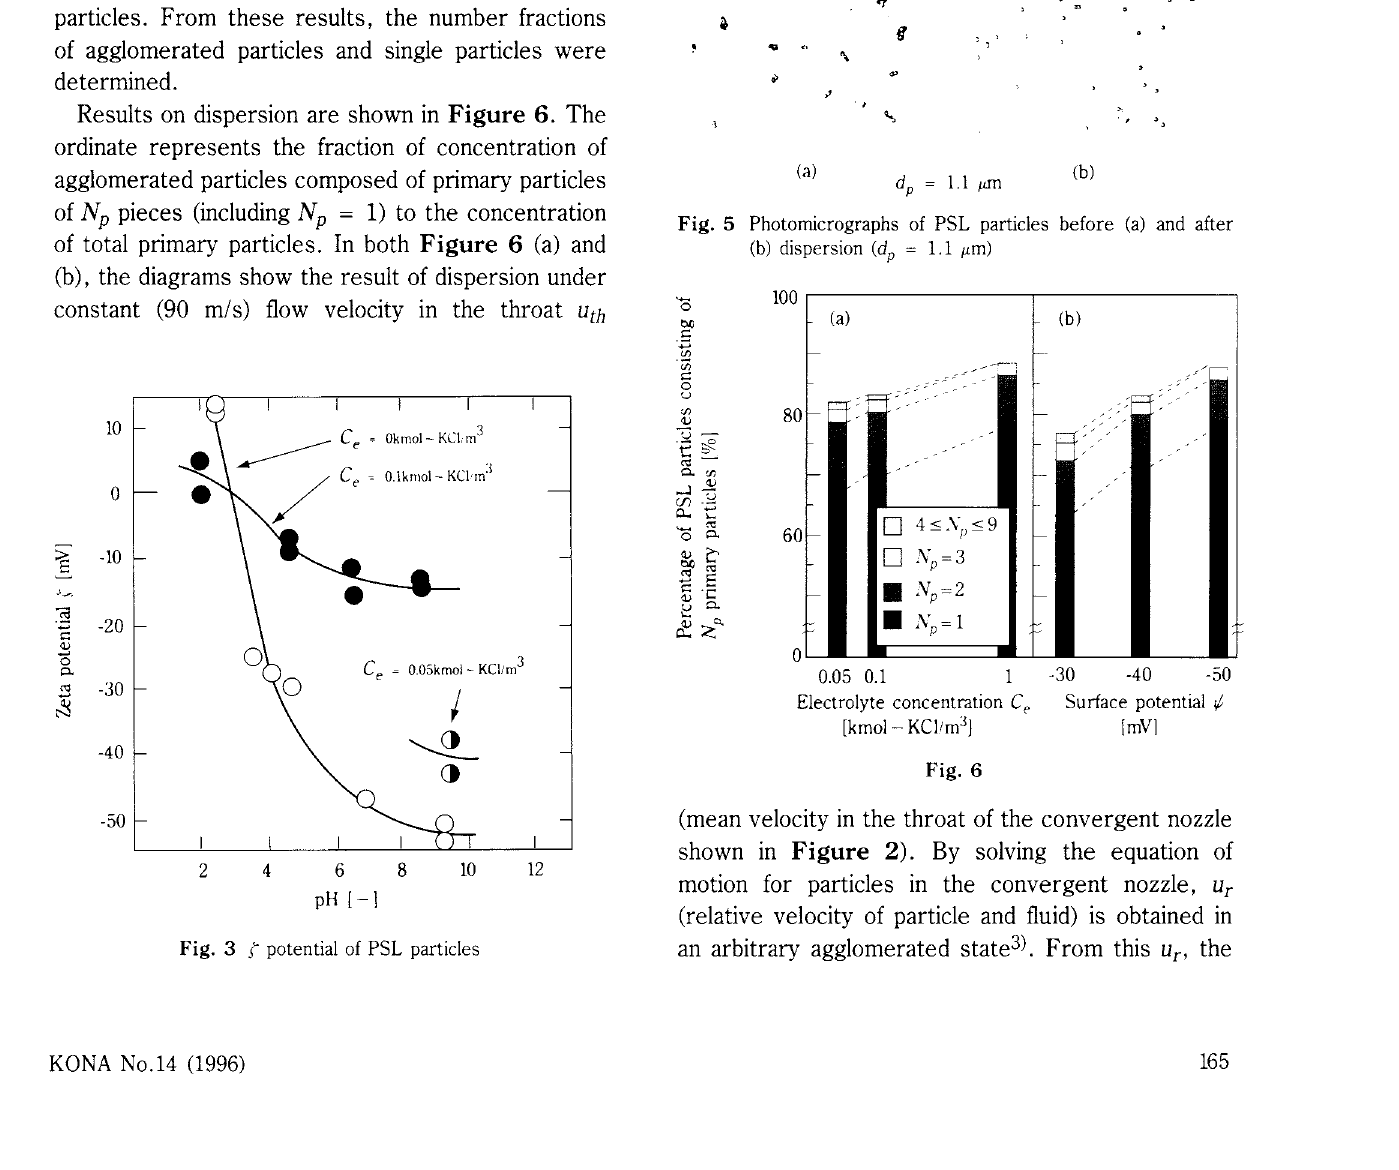
Fig. 4 Electrostatic potential around a spherical particle